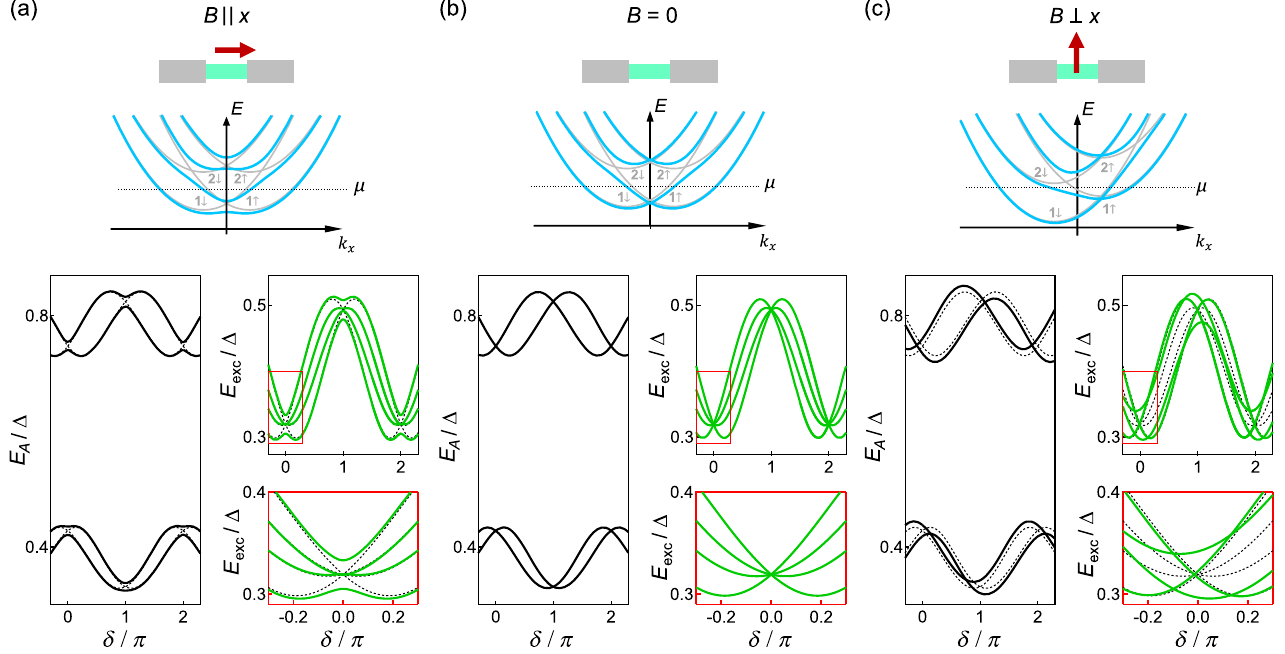
FIG. 7. Effect of an in-plane magnetic field on the band structure (top row), the Andreev levels (bottom row, left) and the excitation spectrum (bottom row, right). (b) Reference graphs at zero field, (a) field applied along the wire axis, (c) field applied perpendicularly to the wire axis. The field effect on the band structure is exaggerated for clarity. The model parameters for the Andreev levels and the excitation spectrum are the same as in Fig. 5 and B ¼ 10